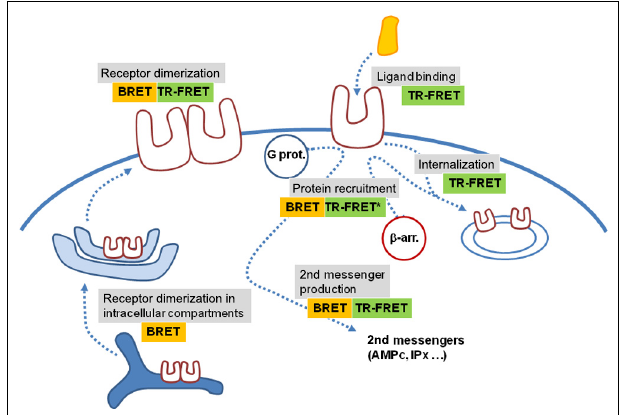
FIGURE 4 | BRET and time-resolved FRET assays application. Various BRET andTR-FRET assays have been developed to measure ligand binding, receptor activation through protein recruitment or second messenger production, receptor dimerization or receptor trafficking. Most of them are compatible with high-throughput screening. Recent developments have shown that these techniques are also potentially compatible with high-content screening, opening new perspectives in the use of RET approaches (*means thatTR-FRET experiments were performed on mildly permeabilized cells expressing C-terminus tagged